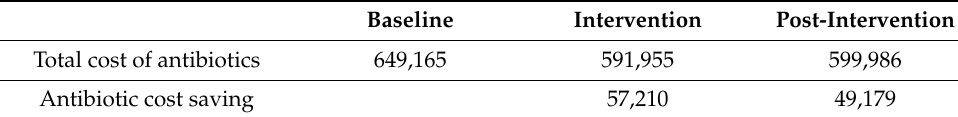
Table 5. Antibiotic cost (USD).